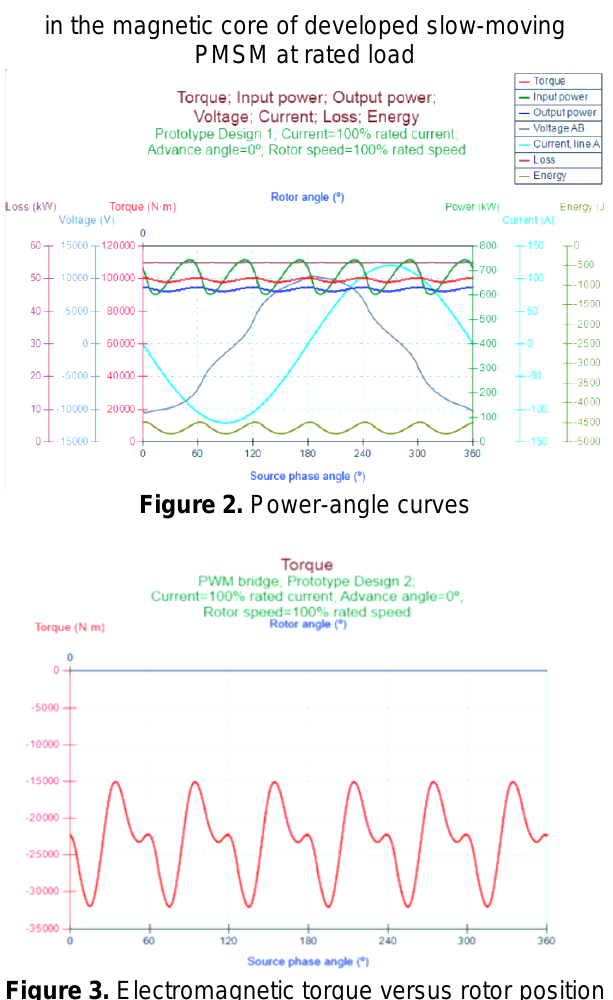
Figure 3. Electromagnetic torque versus rotor position angle relationship at tared stator current